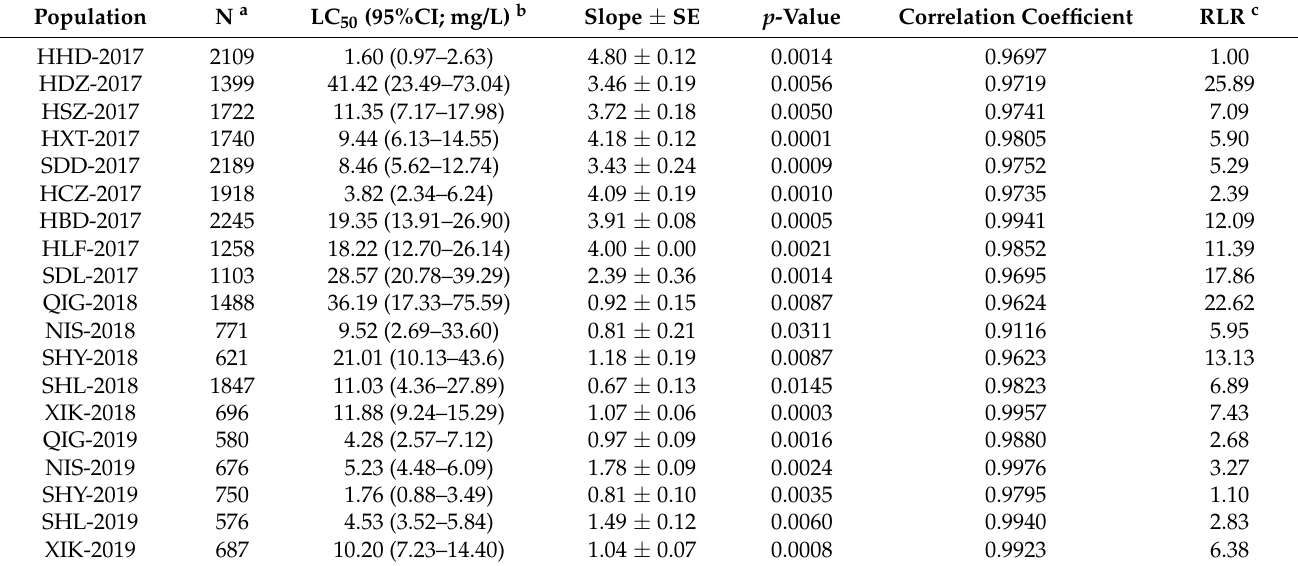
Table 5. Susceptibility of Metopolophium dirhodum field populations to abamectin.